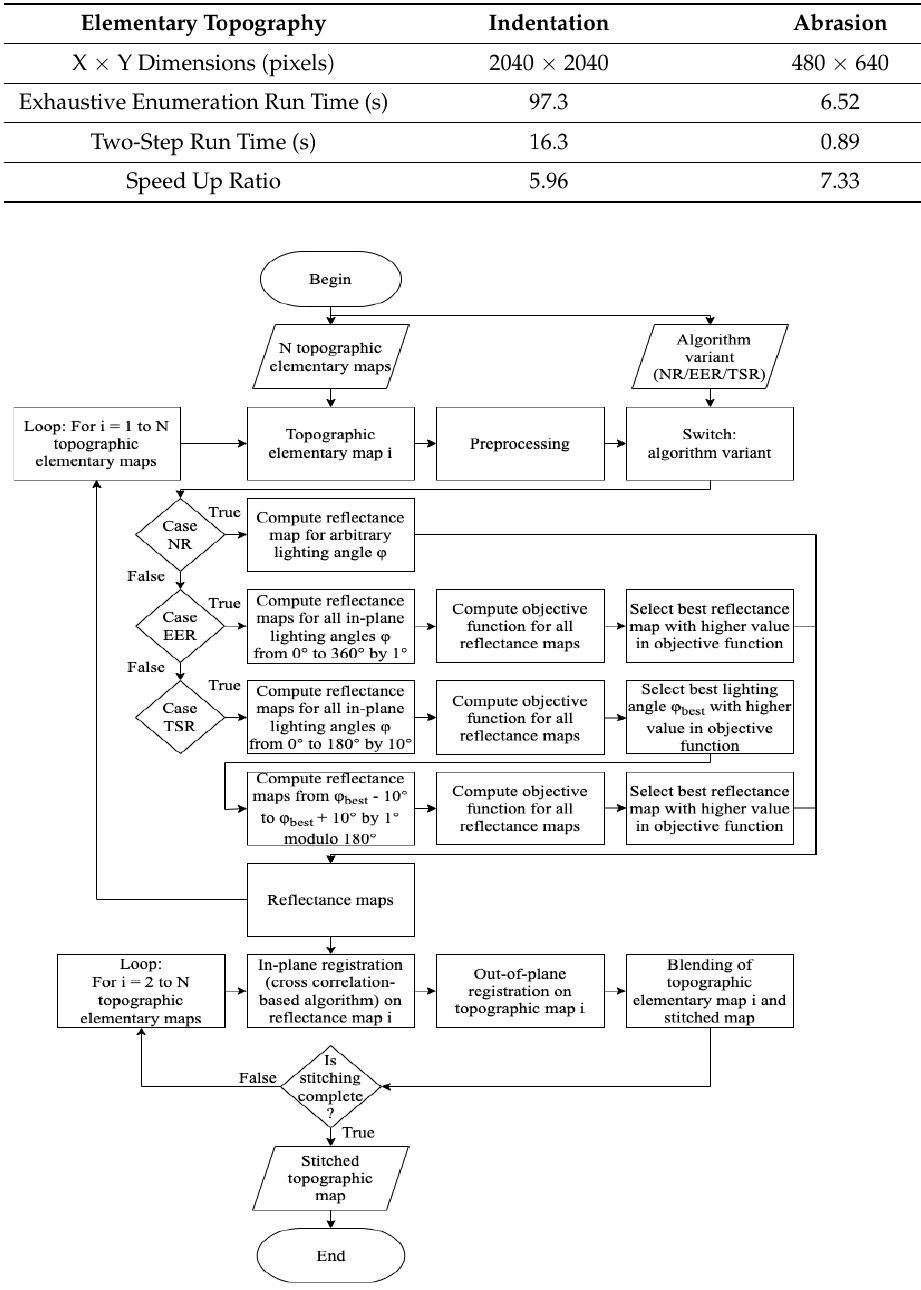
Figure 6. Flowchart of the three variants of the rising sun 3D topography stitching algorithm: the naive reflectance (NR), the exhaustive enumeration reflectance (EER) and the two-step reflectance (TSR).